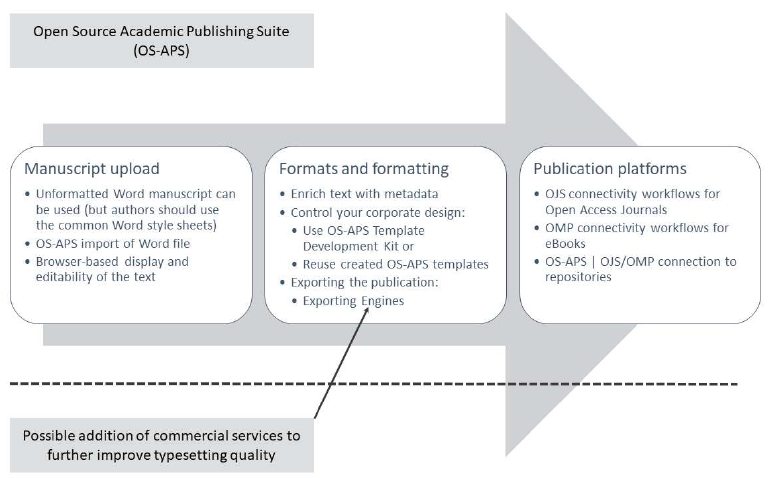
Figure 2. Overview over the Open Source Academic Publishing Suite functionalities.